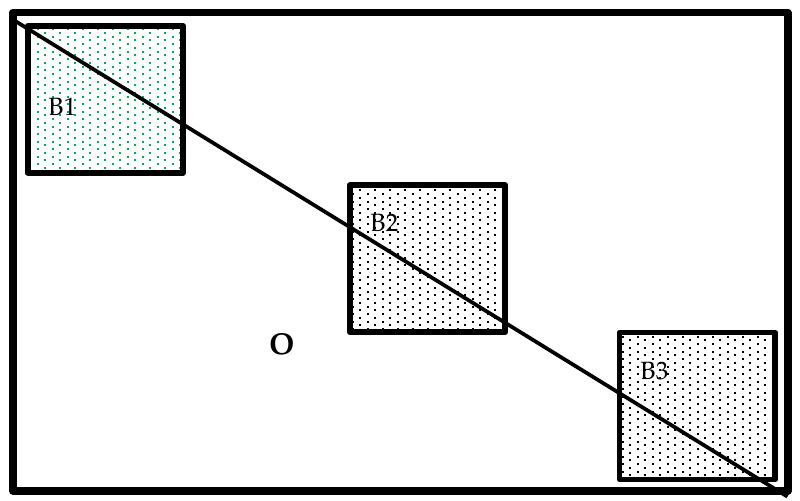
Figure 1. Experimental layout. O = orchard; B1 = Block 1; B2 = Block 2; B3 = Block 3.